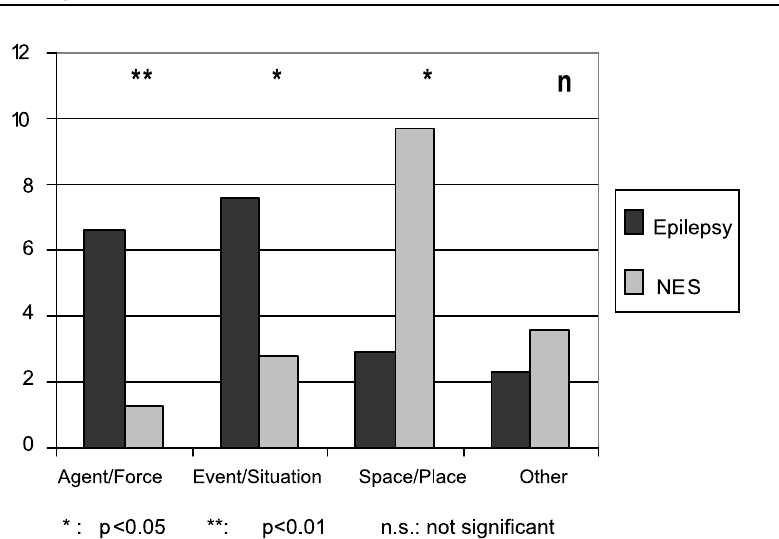
Fig. 2. Preference of metaphoric conceptualisations by patients with epilepsy or NEAD (from